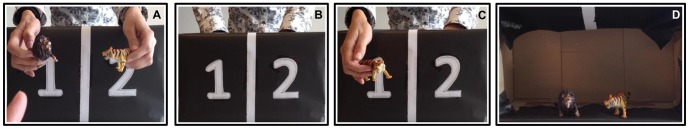
Demonstration of the procedure of a manipulated trial of Experiment 2.
A. Participants select one of the two presented toys, deciding either which one they like better (high self-relevance) or which of the two animals is faster (low self-relevance). No time limit is imposed. B. The experimenter puts both toys back into the box through the two openings on the top and switches the two toys in her hands for this manipulated trial. C. The experimenter extracts the non-selected toy from the opening which previously seemed to contain the selected toy. D. Rear view of the used box. The absence of a division within the box allows for a switch of the different toys in manipulated trials.